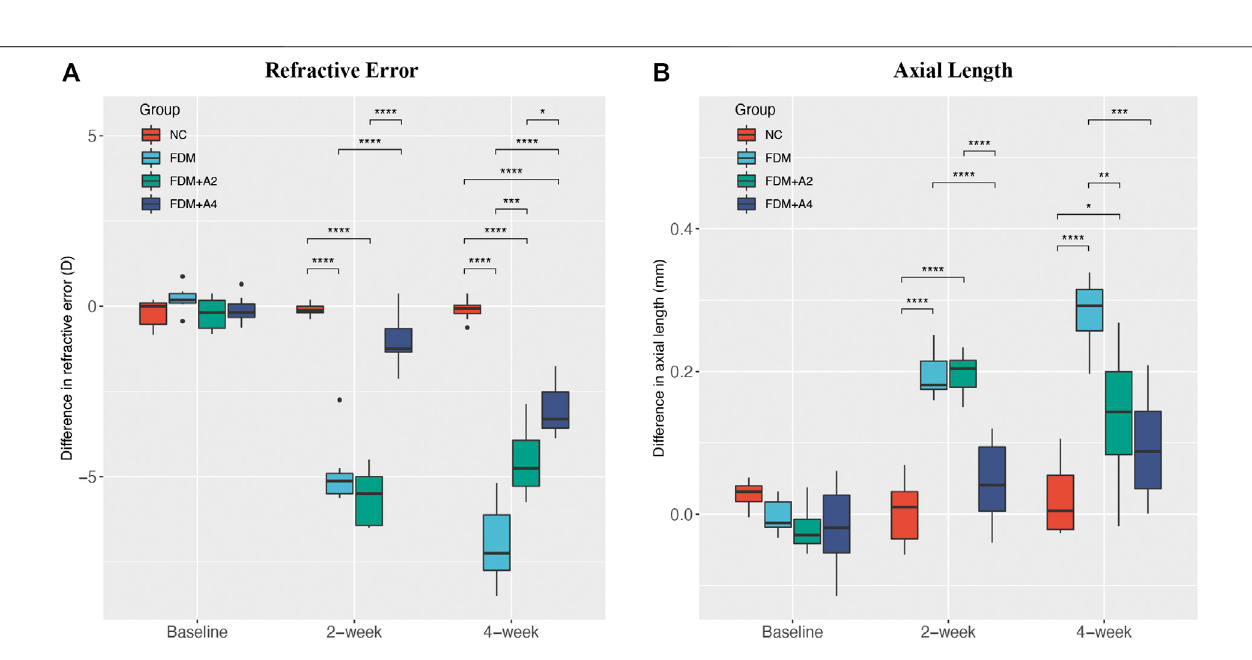
Frontiers in Pharmacology |